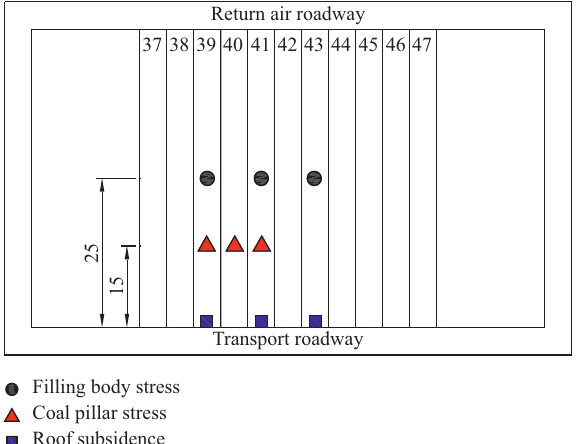
Figure 12: Schematic diagram of the measuring point